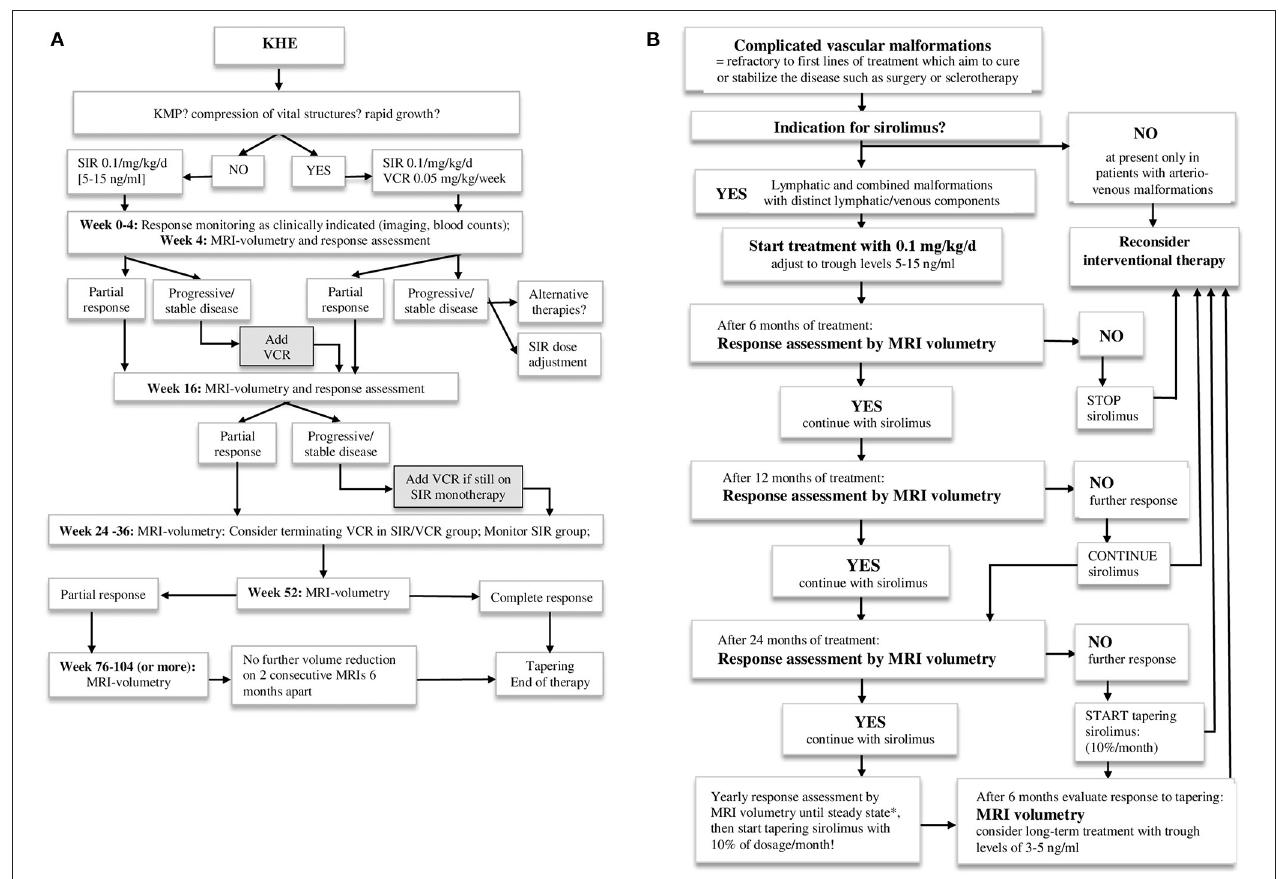
FIGURE 1 | (A) Treatment approach for patients with kaposiform hemangioendothelioma. KHE, kaposiform hemangioendothelioma; KMP, Kasabach-Merritt phenomenon; SIR, sirolimus; VCR, vincristine. (B) Treatment approach for patients with complicated vascular malformations. *Steady state is defined as a stable disease in two consecutive MRT volumetries at least 6 months